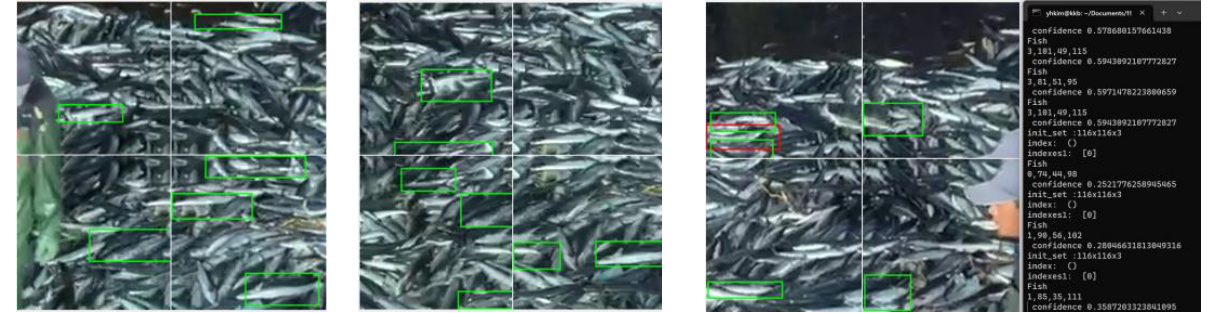
Figure 15. Example of detection result through additional learning.